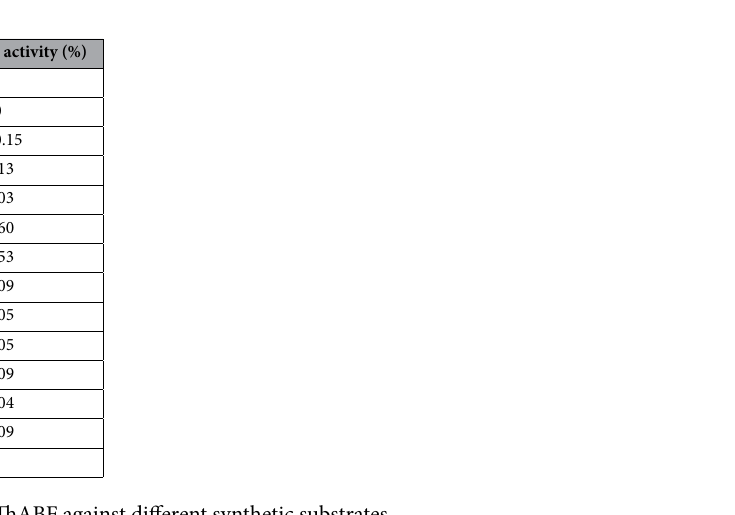
Table 1. Relative activity of ThABF against different synthetic